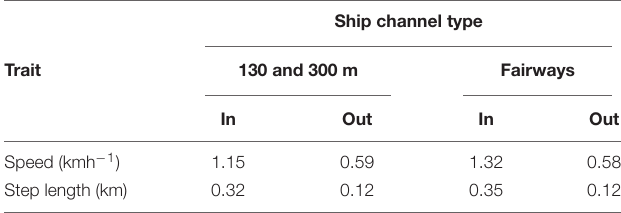
TABLE 4 | Estimated average speed and step lengths of tagged manatees inside and outside of 130 and 300 m boat channels and shipping